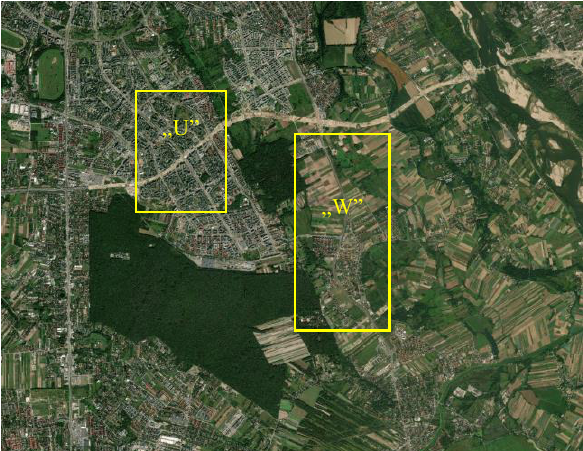
Figure 4. Test areas in Warsaw city (Poland): Wilanów district “W” and Ursynów district